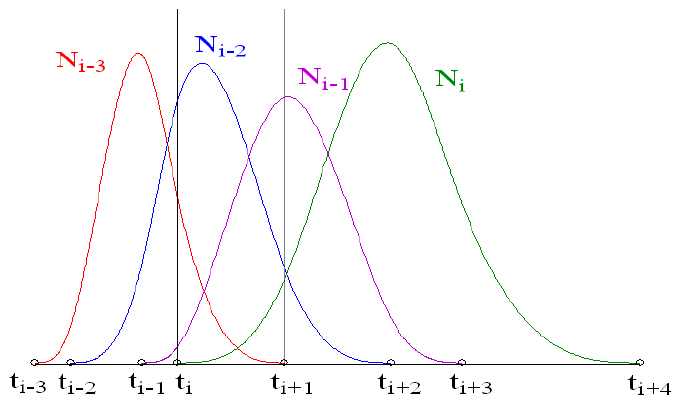
( t ) , each defined on four consecutive intervals. In 3 tN i , each defined on four consecutive intervals. In the i